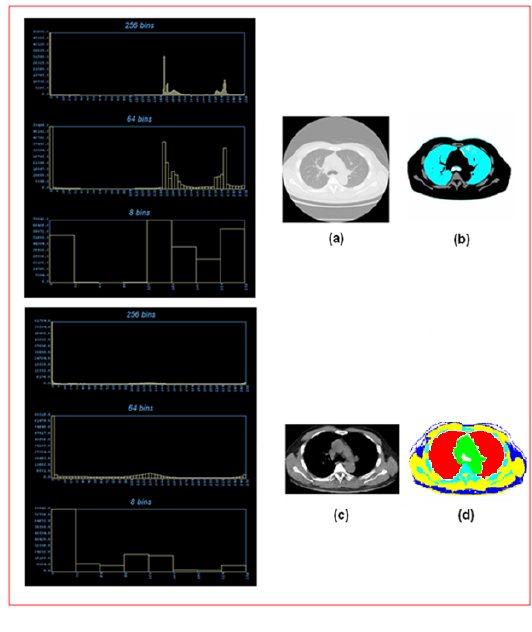
Figure 22. (a) Raw MRI data and its histogram before pre-processing (b) Segmentation of part a (c) Raw MRI data and its histogram after pre-processing (d) Segmentation of part c.